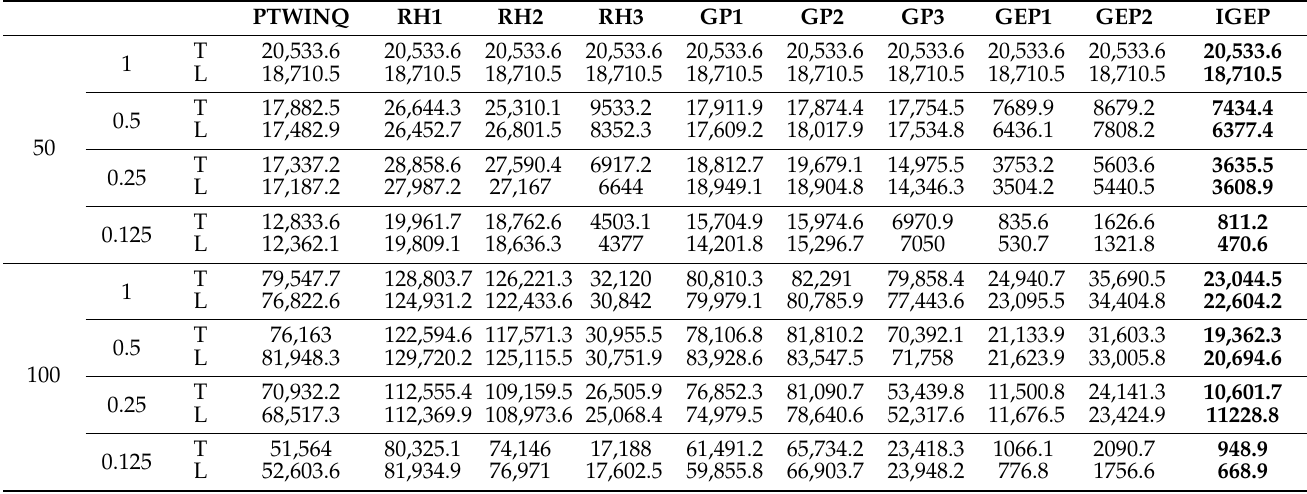
Table 3. Comparison of discovered/combination rules with minimum